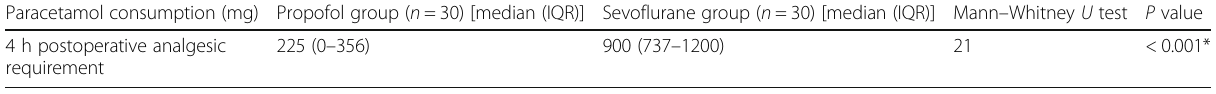
Table 5 Postoperative paracetamol consumption